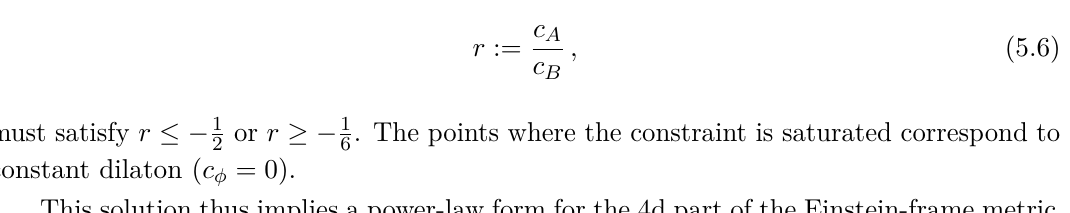
, d , c , d . The external Einstein equations give, cf. A A φ φ